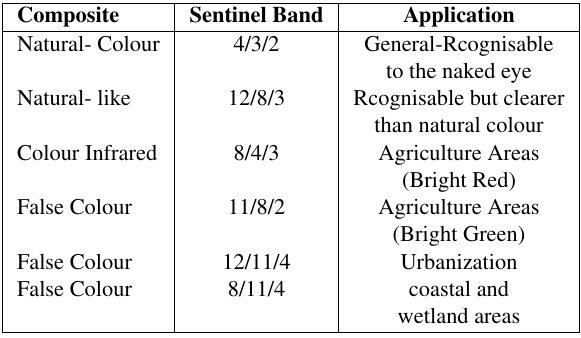
Table 2: Band Combination For Sentinel